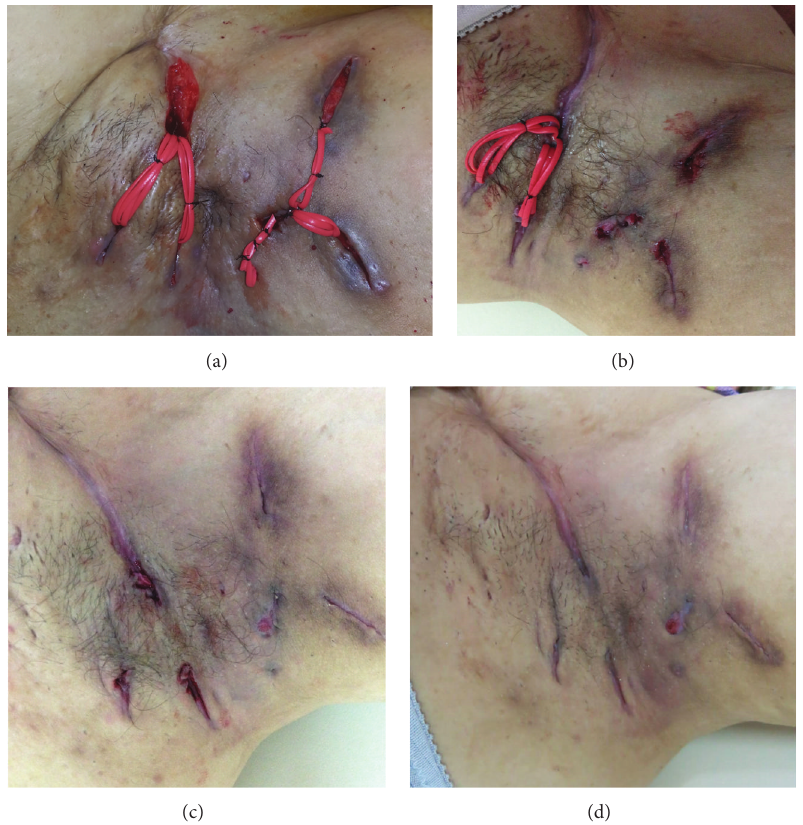
Figure 2: (a) Day 0 left axilla postoperatively showing five fistula tracts with setons insertion. ((b), (c), and (d)) Showing the progress of the left axilla at 4, 6, and 8 weeks postoperatively, respectively, and showing healing of all wounds and complete resolution of the